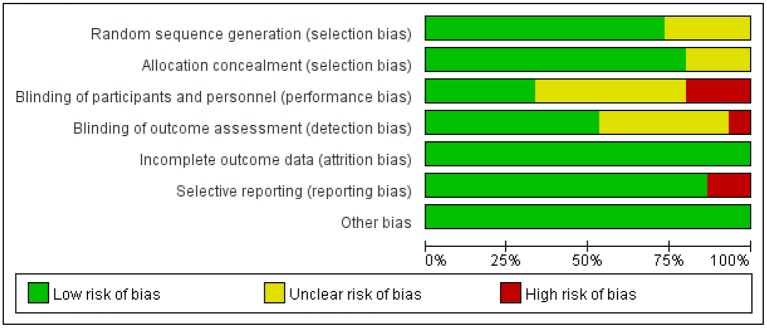
Assessment of risk of bias in randomized controlled trials.